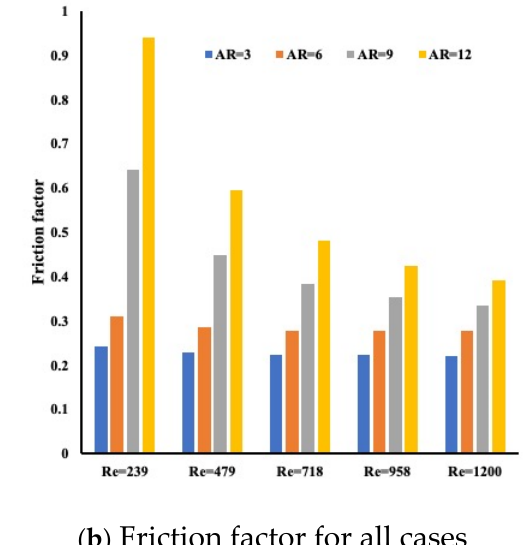
Figure 3. Temperature and local Nusselt number variation for different Reynolds numbers (AR = 6) (dp = 31 nm). As indicated earlier, the model is solved for all four aspect ratios for all Reynolds numbers. As shown in Figure 4a, a comparison between all cases shows that the average Nusselt number increases as the Reynolds number increases. The highest Nusselt number is found for the aspect ratio of 12, meaning full-height mini channels. In addition, as the aspect ratio increases, the average Nusselt number increases accordingly. The friction factor which relates the fluid entry condition to the pressure drop is shown in Figure 4b. The higher aspect ratio exhibits a high friction factor. This is obvious because the flow is in direct contact with the channel wall; thus, there is a large pressure drop.